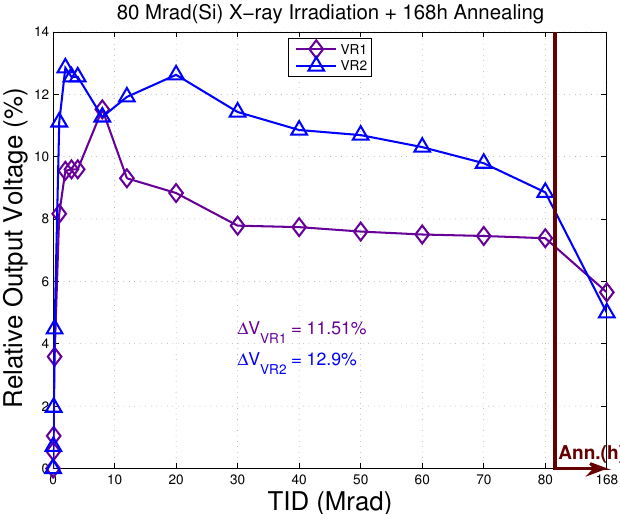
Figure 18. Relative output voltage (%) for the VR1 and VR2 when exposed to a 10 keV X-rays at a dose rate of 300